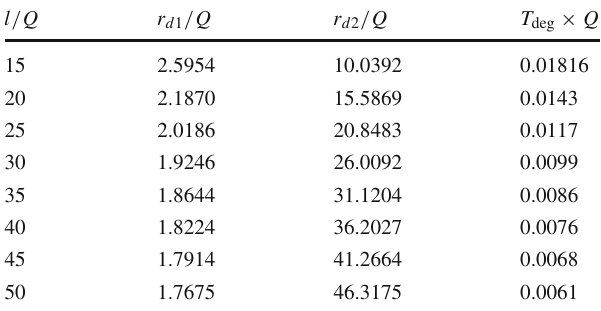
Table 3 The numerical results of the reduced degenerate tempera- ture T deg / Q and the corresponding reduced event horizons r d 1 / Q and r d 2 / Q , under the different values of the pressure